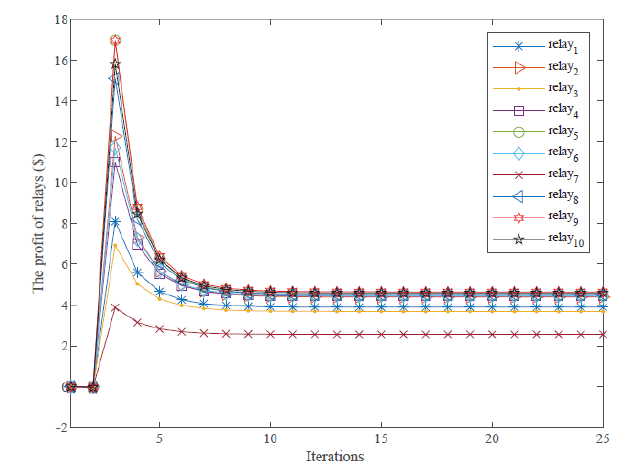
Figure 7. Convergence of the algorithm.